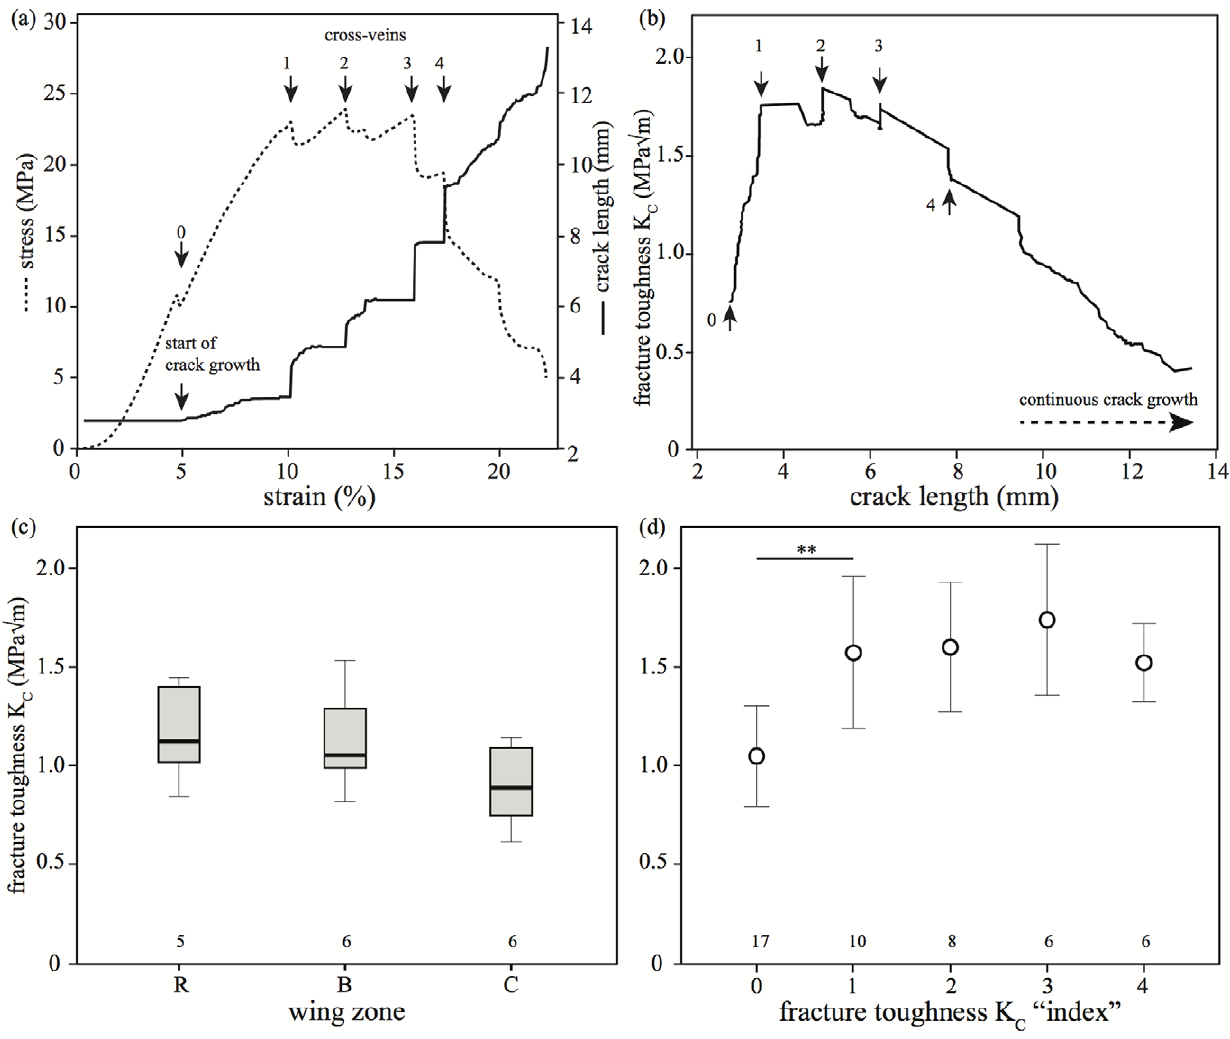
Figure 2. Crack propagation and fracture toughness of hind wings. (a) Stress-strain curve and corresponding crack length from one wing sample with an induced notch. The numbers indicate the K C indices (see text). With increasing strain the stress on the wing membrane increases until the crack starts growing (0). When reaching cross veins (1–4), the crack propagation temporarily stops and the stress further increases. When the cross veins break, the stress decreases and the crack continues to propagate. (b) Crack length and corresponding fracture toughness K C . The markers 0–4 correspond to the markers in (a). (c) Fracture toughness of hind wing membrane. Although slightly decreasing towards the anal part of the wing, there was no significant difference in-between the fracture toughness K C0 of the membrane from the tested three wing zones (F 2,16 =2.087, p . 0.1, ANOVA). (d) The membrane alone had a mean fracture toughness of 1.04 6 0.25 MPa ! m (N=17). The presence of the first cross-vein (index 1) significantly increased the fracture toughness of the wing structure to 1.57 6 0.38 MPa ! m (t 9 = 2 3.513, p , 0.01, paired t-test, both figures show